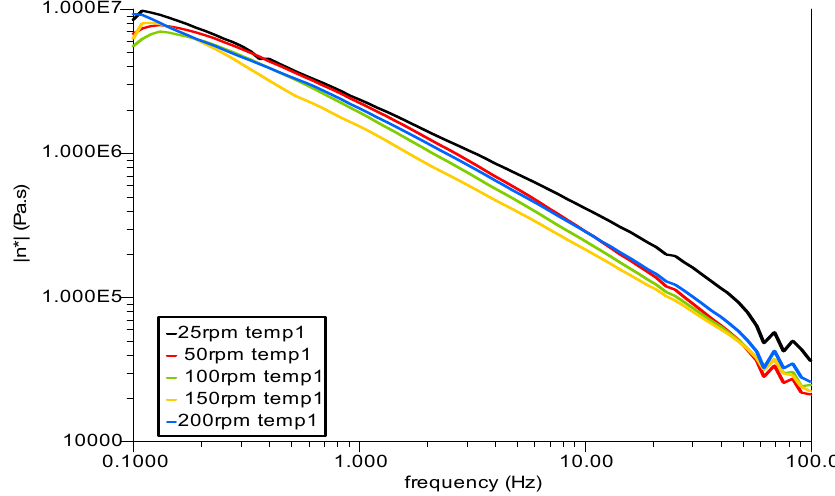
Figure 7. Complex viscosity ( η *) versus frequency (Hz) for novel SSB ® 55 Pharma grade Shellac at various screw speeds.